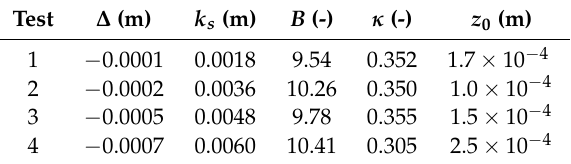
Table 5. Parameters describing the log-law for Scenario 3, where κ is not considered universal.